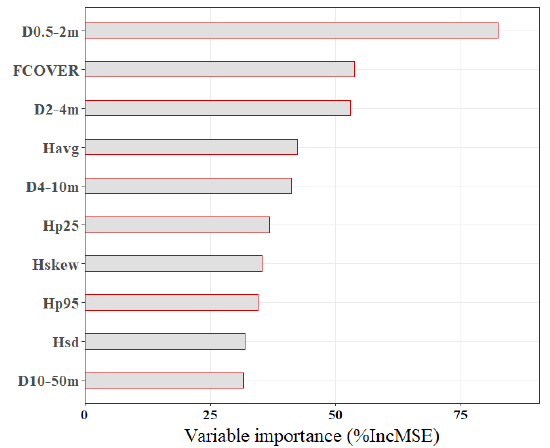
Figure 4. Variable importance (%IncMSE) of the pre-fire LiDAR metrics in the Random Forest (RF) regression algorithm.